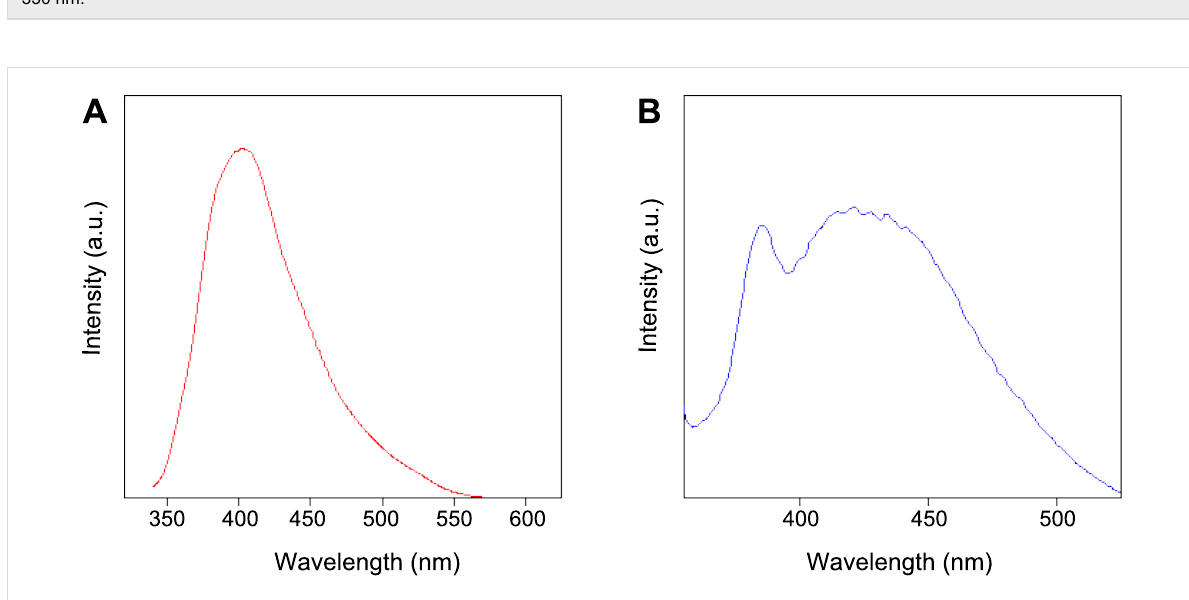
Figure 7: (A) Fluorescence spectra of Gd 2 O 3 nanoparticles excited at 320 nm giving emission at 400 nm and (B) Gd 2 O 3 –taxol bioconjugate excited at 320 nm giving emission at 440